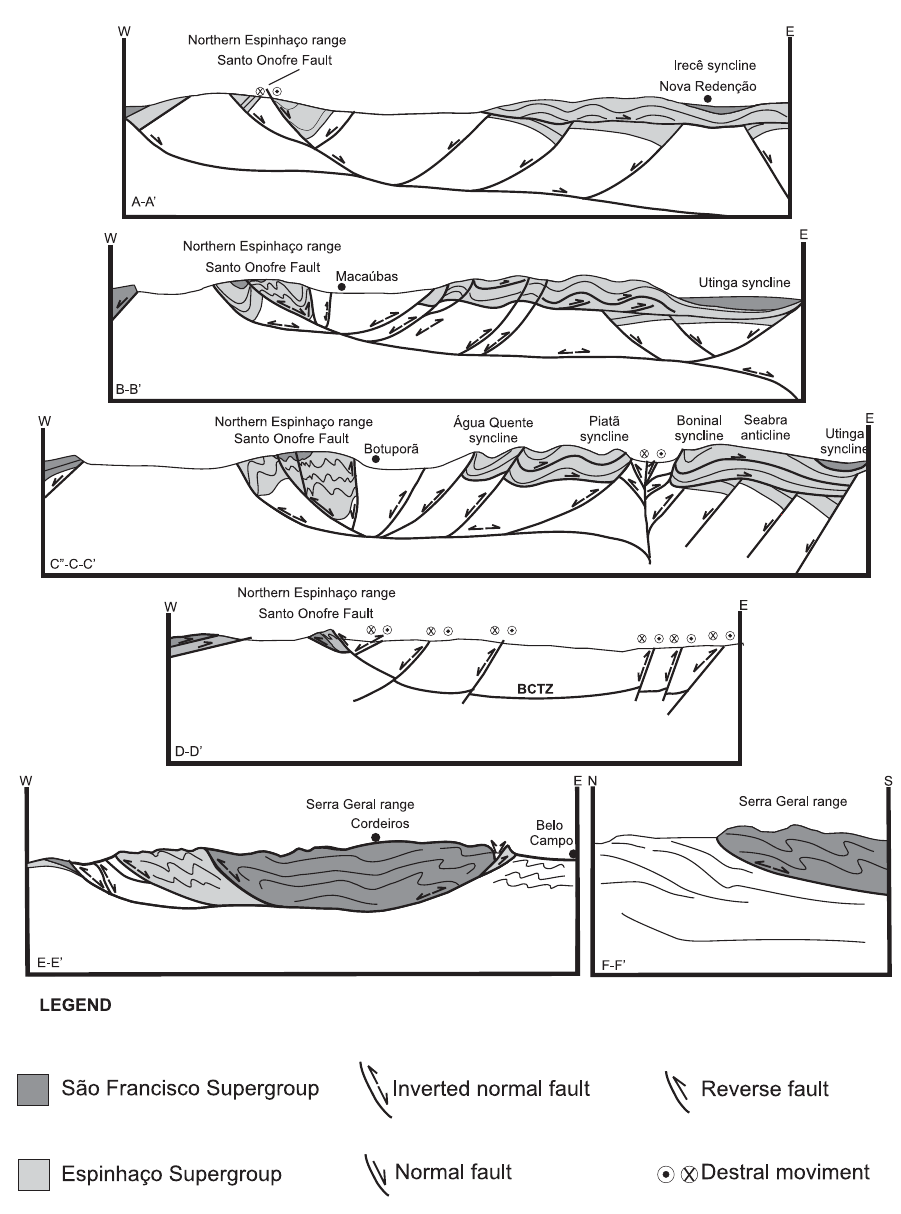
Fig. 5 – Cross-sections of the southern Paramirim corridor and Rio Pardo salient. The sections A-A’ and B-B’ incorporate modifications from sections by A. Danderfer F Brumado-Caetité shear